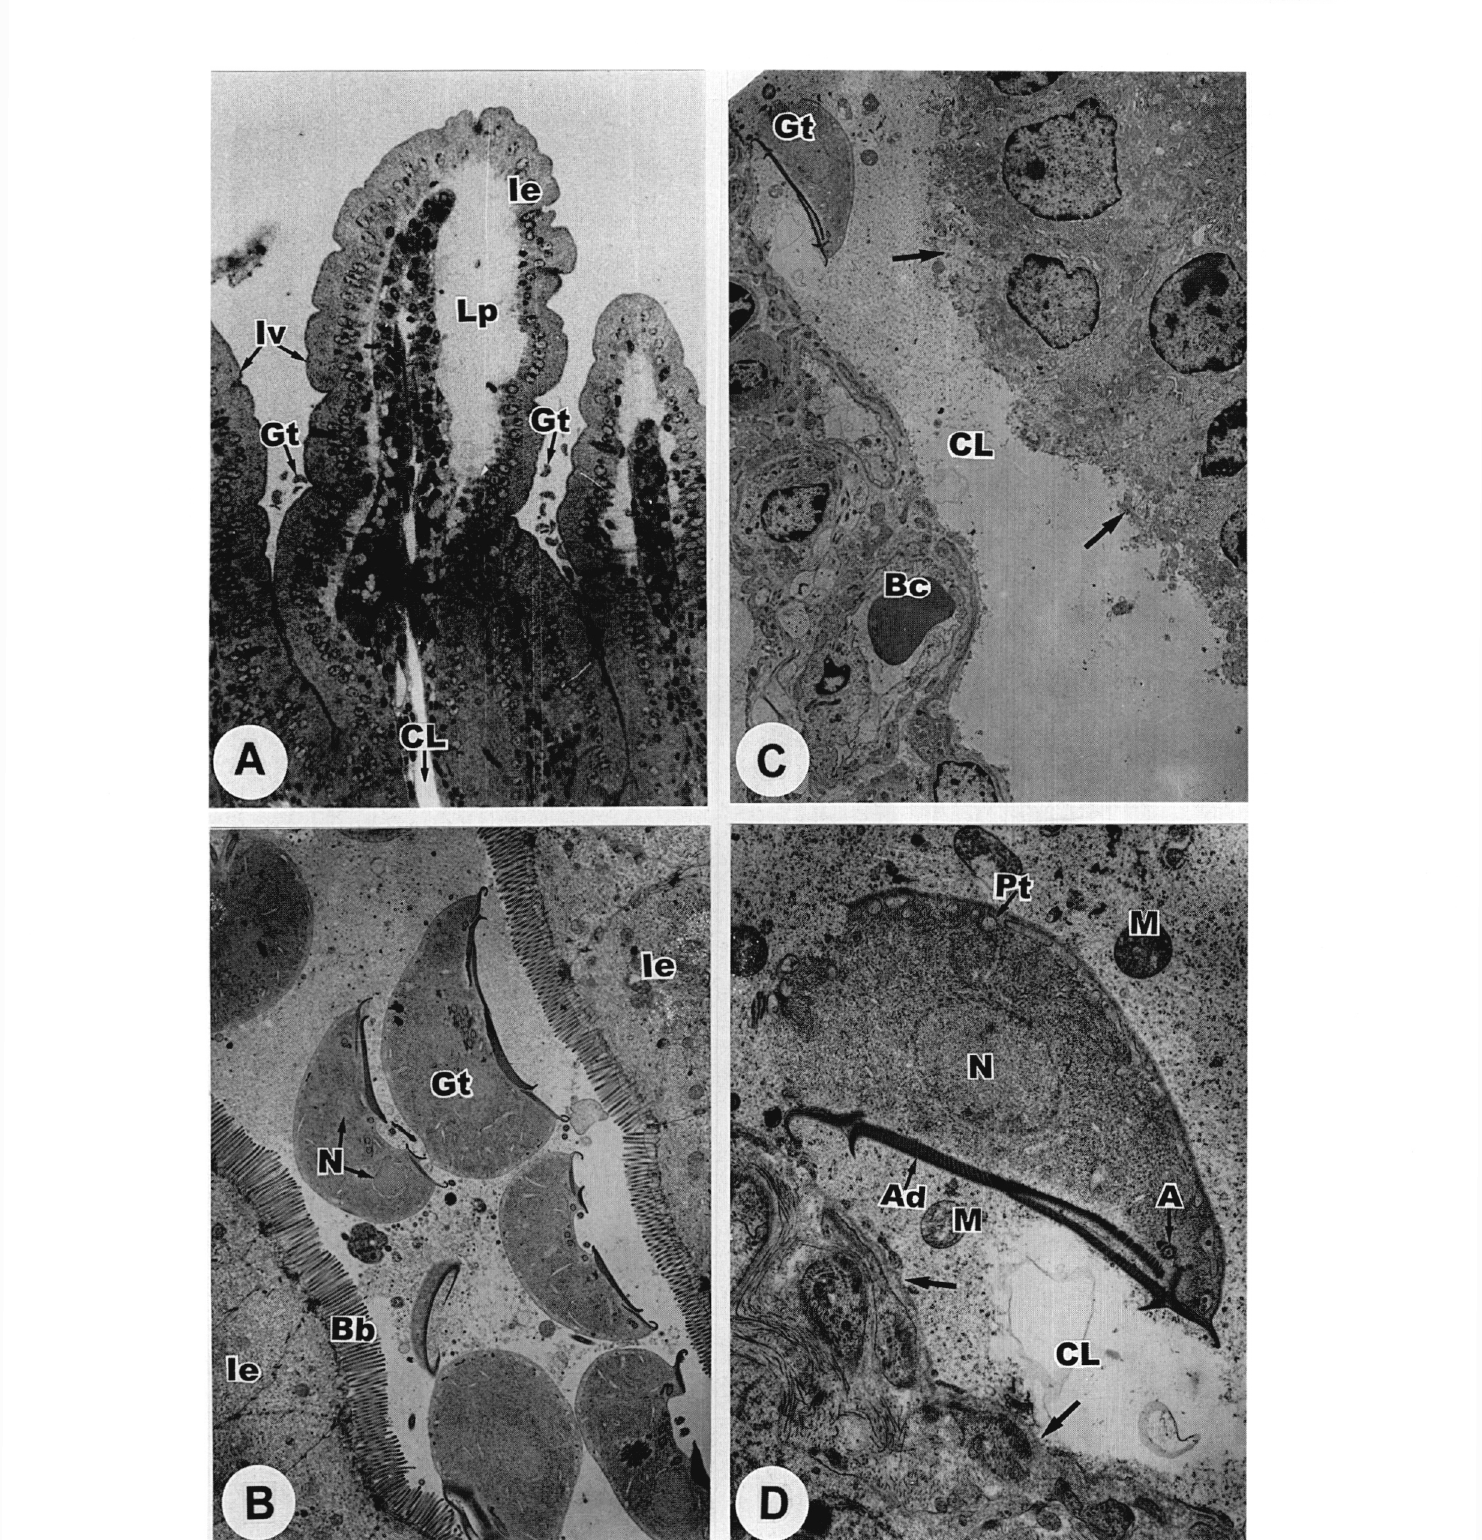
Fig. 1. - A : Light micrograph of semithin section from naturally infected mouse duodenum demonstrating intestinal villi (Iv), covered with the intestinal epithelium (Ie). Many Giardia trophozoites (Gt), are demonstrated in between the villi. Lamina propria (Lp). Central lacteal (Cl), x 500. - B : Transmission electron microscopic (TEM) picture of the same section in A, showing heavy intestinal infection with Giardia trophozoites (Gt). Intestinal villi (Iv). Intestinal epithelium (Ie). x 4,500. — C : TEM of intestinal villous demonstrating Giardia trophozoites (Gt), within central lacteal (Cl). Arrows pointed to necrotic lymphatic wall. Blood capillary (Bc). Intestinal epithelium (Ie). x 3,600. - D : Higher magnification of the Giardia trophozoite seen in C. Adhesive disc (Ad). Nucleus (N). Peripheral tubules (Pt). Mitochondria (M). Axoneme (A). Central lymphatic (Cl). Big arrows pointed to the lymphatic wall, x